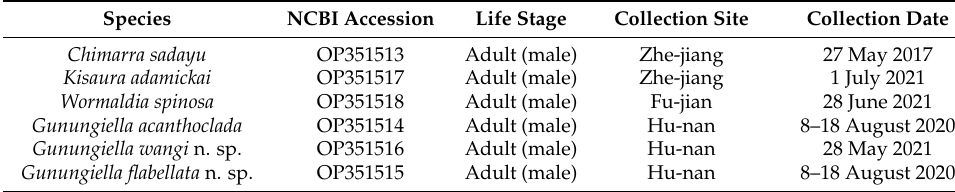
Table 2. Specimens used in phylogenetic